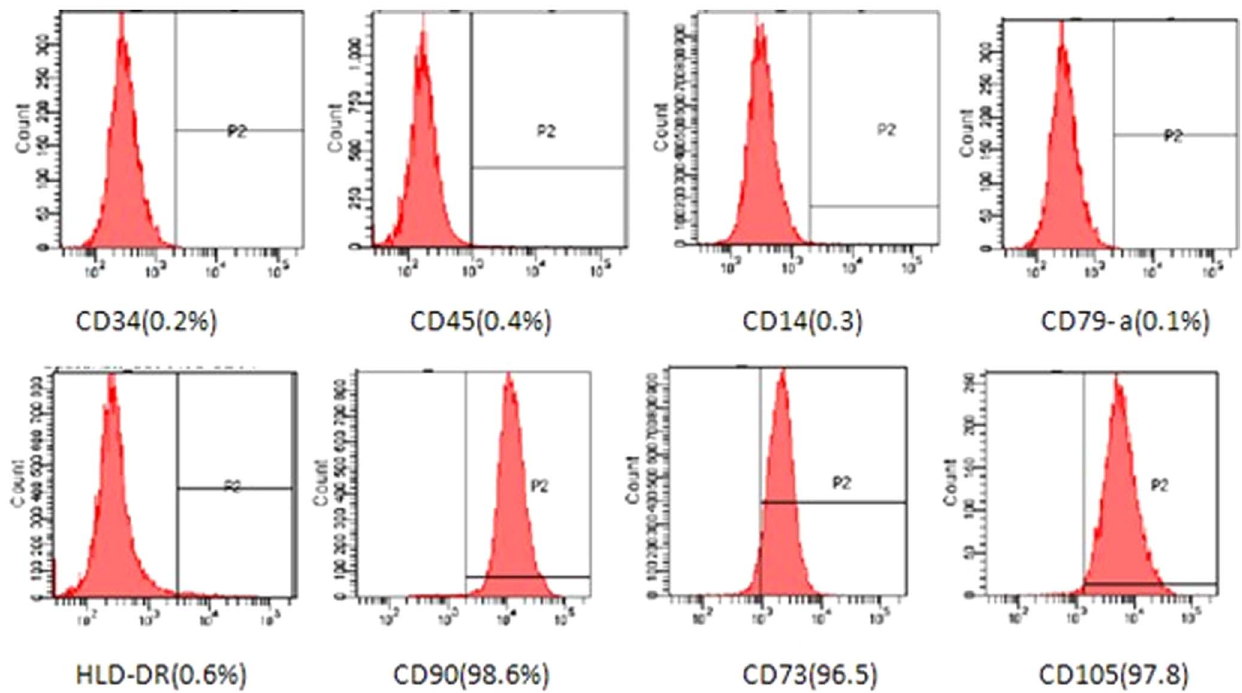
Figure 2. Analysis of MSCs for the expression of surface markers by flow cytometric analysis. The immunofluorescence analysis of MSCs was conducted at the 15 th passage of cells obtained from donor